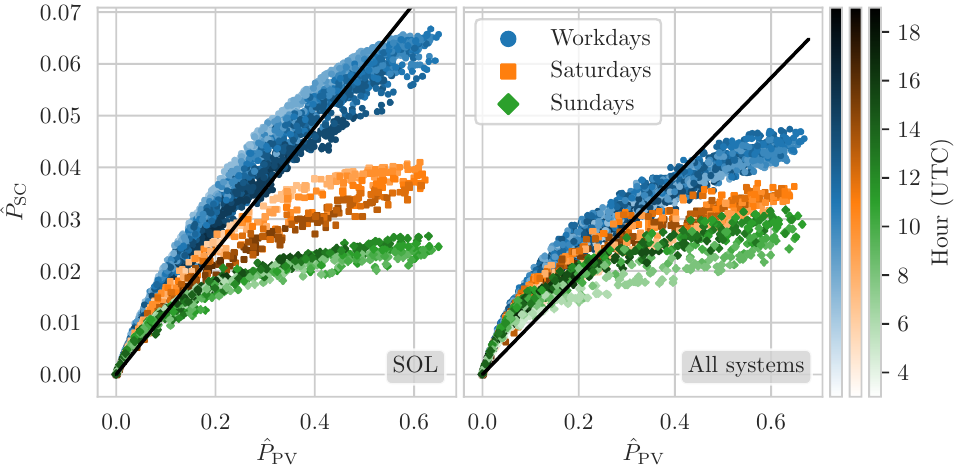
Figure 6. Dependency of self-consumption on PV generation and time of day for the SOL ( left ) and the complete model ( right ) portfolios. The scatter symbols show the specific self-consumption ˆ P SC and PV generation ˆ P PV for each time step separated into workdays (blue circles), Saturdays (orange squares) and Sundays (green diamonds). The colours are shaded by the time of the day from morning (light) to evening (dark). The black lines indicate the relation between self-consumption and PV generation as predicted by the linear “PV-scaled” reference model based on the modelled overall self-consumption